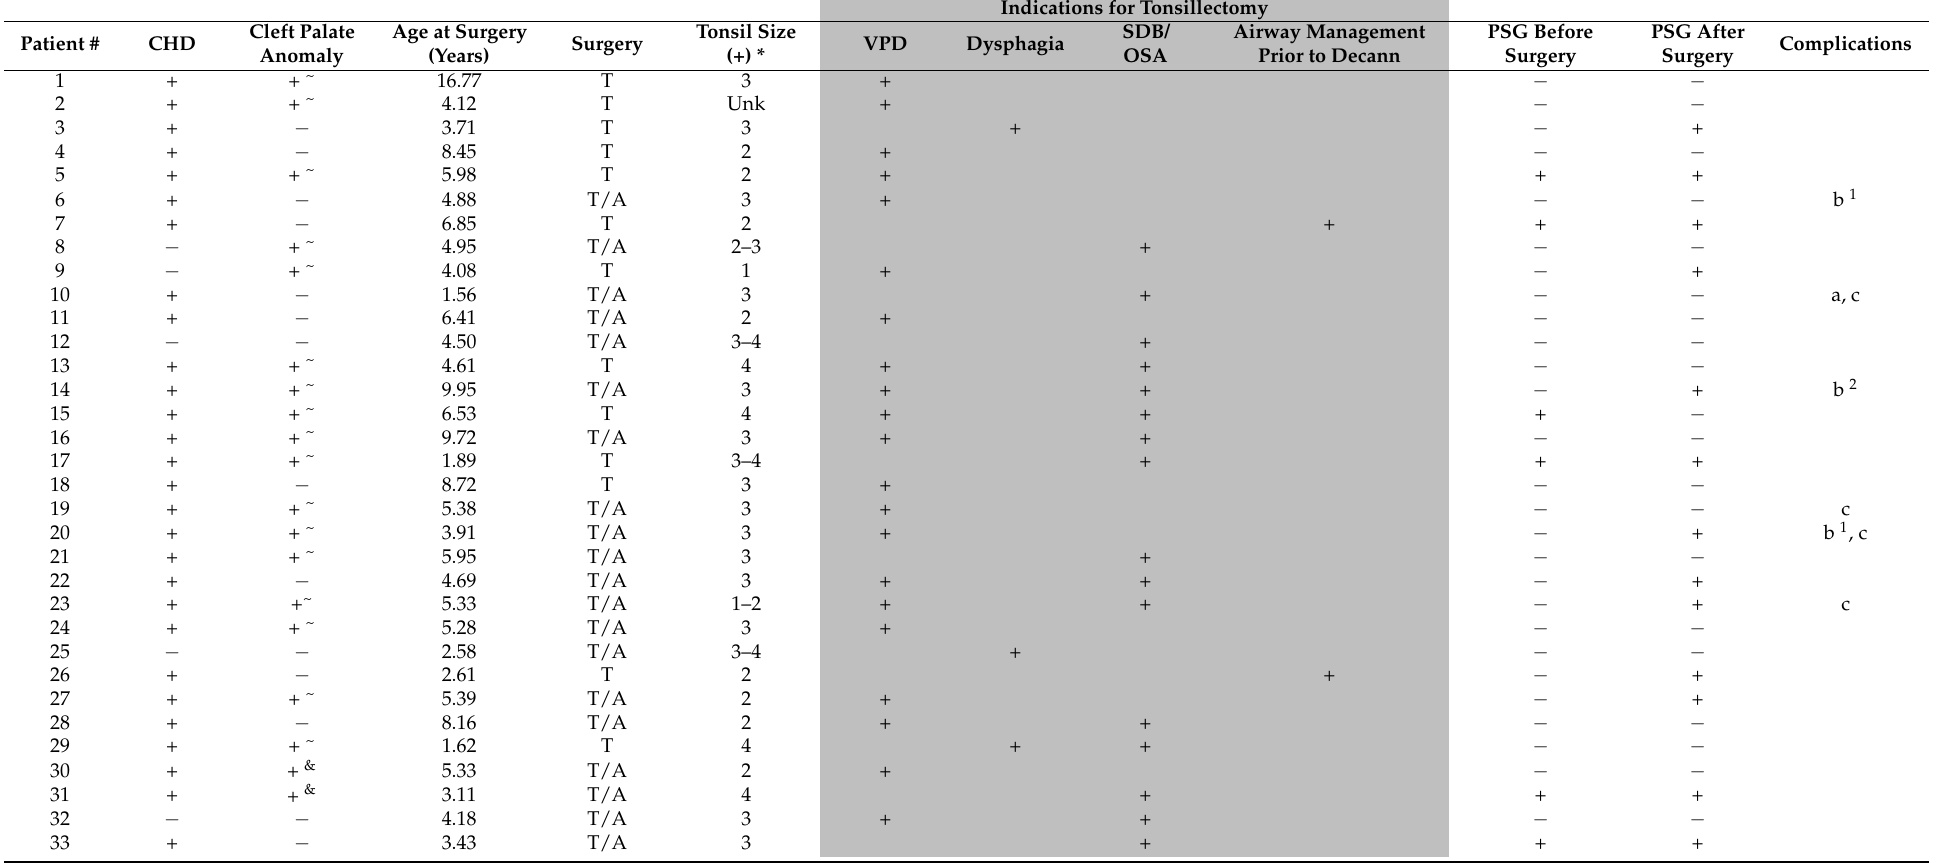
Table 1. Data Summary for Patients with 22q11DS and Tonsillectomy. The shaded area contains all indications for tonsillectomy for each